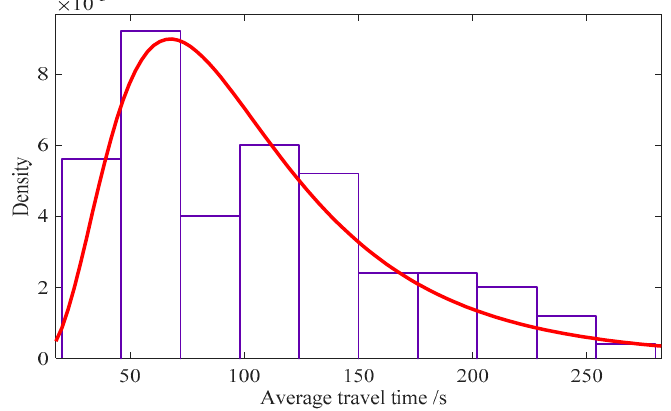
Figure 4. Probability histogram and probability density function (PDF) curve of average travel time based on license plate recognition (LPR) data. Table 1. Parameters and goodness of fit test results of three average link travel time distributions.